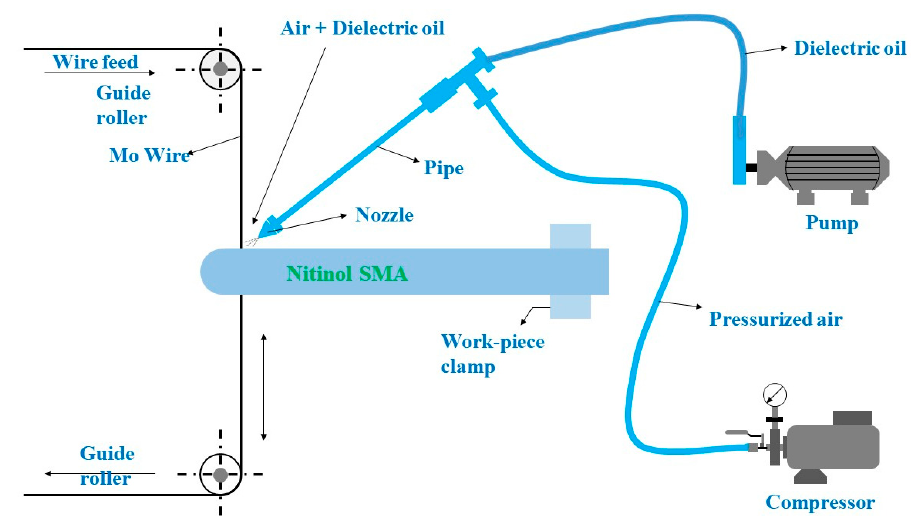
Figure 1. Schematic of the near-dry WEDM.